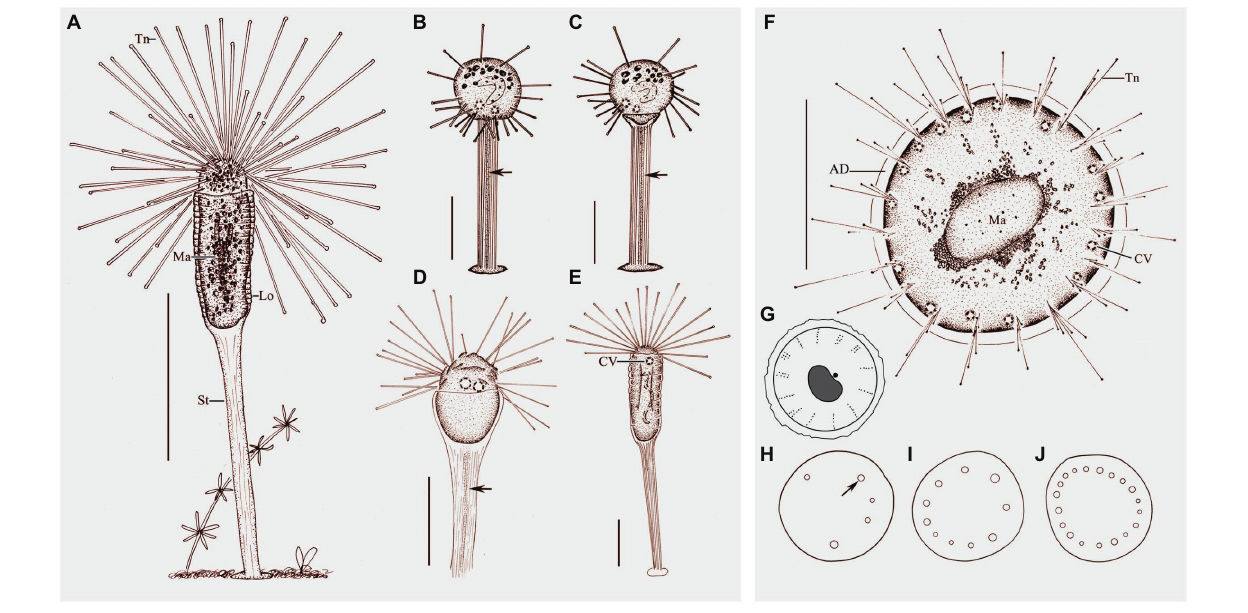
symmetrical, champagne glass-shaped, 60–210 μ m × 20–80 μ m,